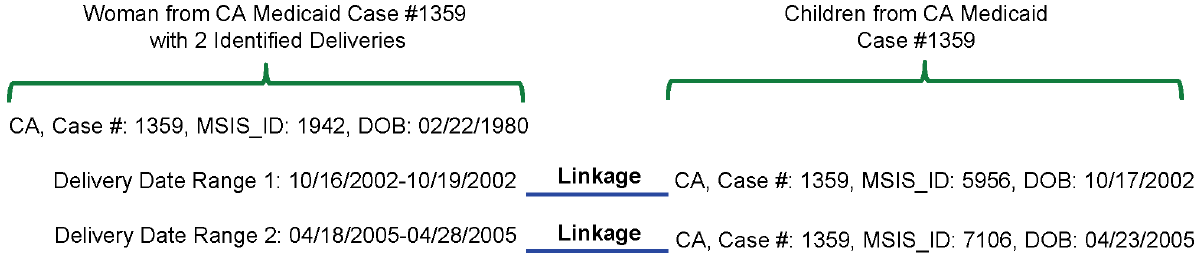
Figure 2. Hypothetical example of woman-infant linkage by state, Case Number, and delivery date range/date of birth. CA, California.